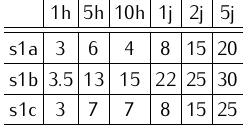
Table 4. Variation of the mean noise level (in nstrain) for s1a, s1b and s1c with dominant period of observation (high-passed signal in